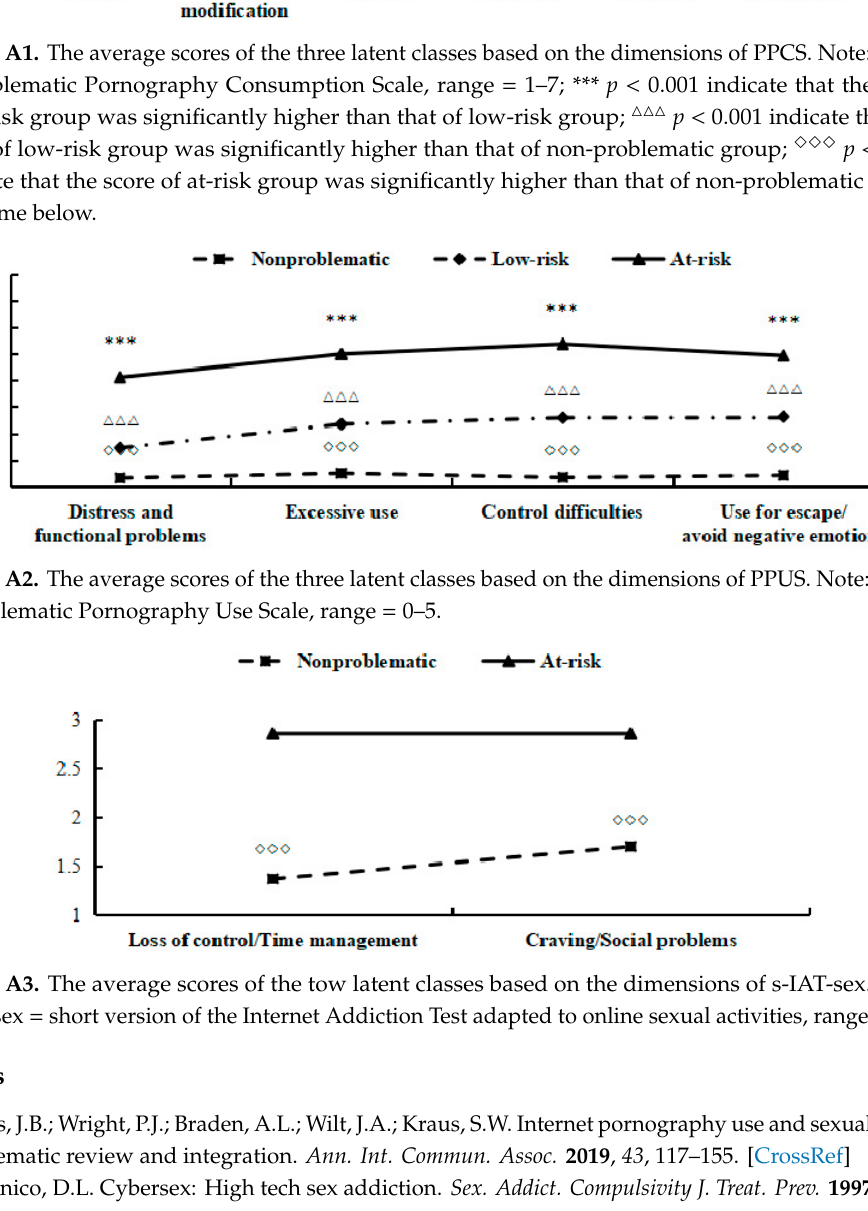
Figure A3. The average scores of the tow latent classes based on the dimensions of s-IAT-sex. Note: s-IAT-sex = short version of the Internet Addiction Test adapted to online sexual activities, range = 1 – 5.